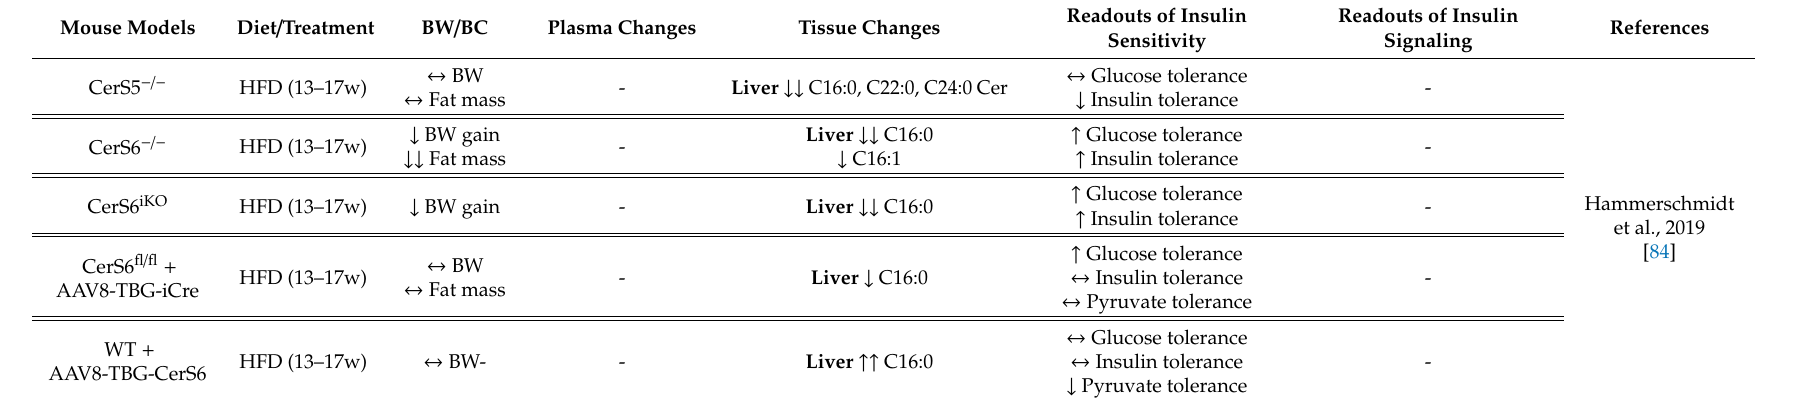
Table legend: ↑ increase; ↑↑ large increase; ↓ decrease; ↓↓ large decrease; ↔ no change; AC acid ceramidase; Akt protein kinase B; AT adipose tissue; BAT brown AT; BC body composition; BW bodyweight; CD chow diet; Cer Ceramide; d day; DAG diacylglycerol; DhCer dihydroceramide; Dox doxycycline; GLUT4 glucose transporter type 4; GlcCer glucosylceramide; GSK3 β glycogen synthase kinase 3 β ; Gys2 Glycogen synthase 2; HE clamp hyperinsulinemic euglycemic clamp; HexCer hexosylceramide; HFD high-fat diet; HOMA-IR homeostatic model assessment for insulin resistance; INSR insulin receptor; LacCer lactosylceramide; LD lipid droplet; MHCer monohexosylceramide; NEFA non esterified fatty acids; PP2A protein phosphatase 2A; S1P sphingosine-1-phosphate; SkM skeletal muscle; SM sphingomyelin; TAG triacylglycerol; w week; WAT white